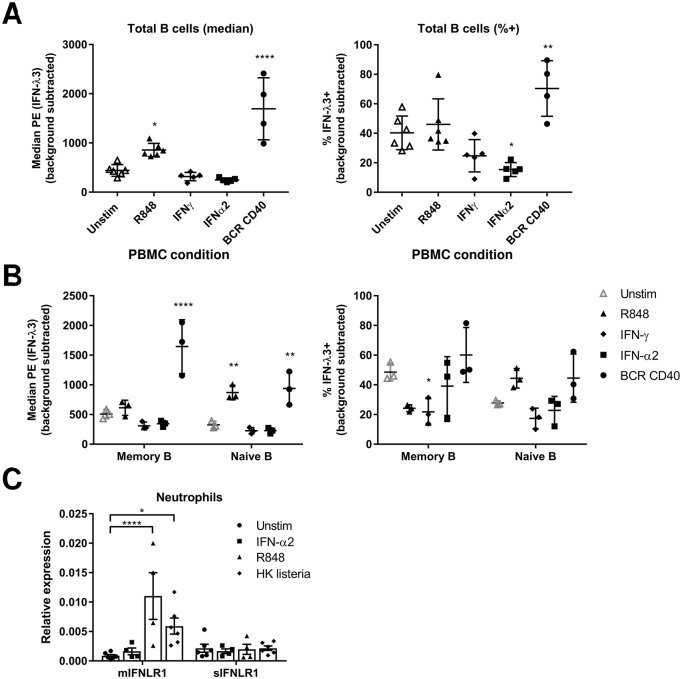
BCR or TLR activation upregulate IFN-λ3 binding and IFN-λR1 expression.A-C) IFN-λ3 (5 μg/ml) binding to LIVE/DEAD- CD20+ B cells (A-B, memory (CD27+), naïve (CD27-)) or CD3+ CD4+ or CD8+ T cells (C) within total PBMCs that had been cultured for 3 days either unstimulated (unstim), or with the following stimuli: R848 (1 μg/ml), IFN-γ (10 ng/ml), IFN-α2 (1000 IU/ml) or anti-IgM/IgG/IgA (BCR, 10 μg/ml) and anti-CD40 (5 μg/ml). The percent IFN-λ3+ or median PE fluorescence is shown after background subtraction of secondary antibody alone with means +/- SD. C) RT-qPCR quantification of sIFNLR1 and mIFNLR1 transcripts in purified neutrophils that were left unstimulated (unstim) or stimulated with IFN-α2 (1000 IU/ml), R848 (1 μg/ml) or heat killed listeria (HK listeria) supernatant (1:100) for 5 hrs. *, P<0.05, **, P<0.01, ****, P<0.0001, one-way ANOVA (A) or two-way ANOVA (B-C), Dunnett’s multiple comparisons test between each treatment and unstimulated. Only significant comparisons are noted and each symbol represents a different individual donor.